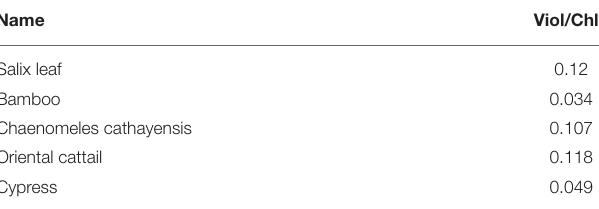
TABLE 3 | Pigment ratios of Viol/Chla in higher